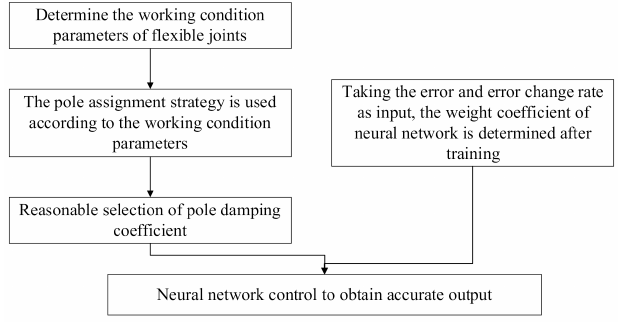
Figure 6. The specific control flow of BP neural